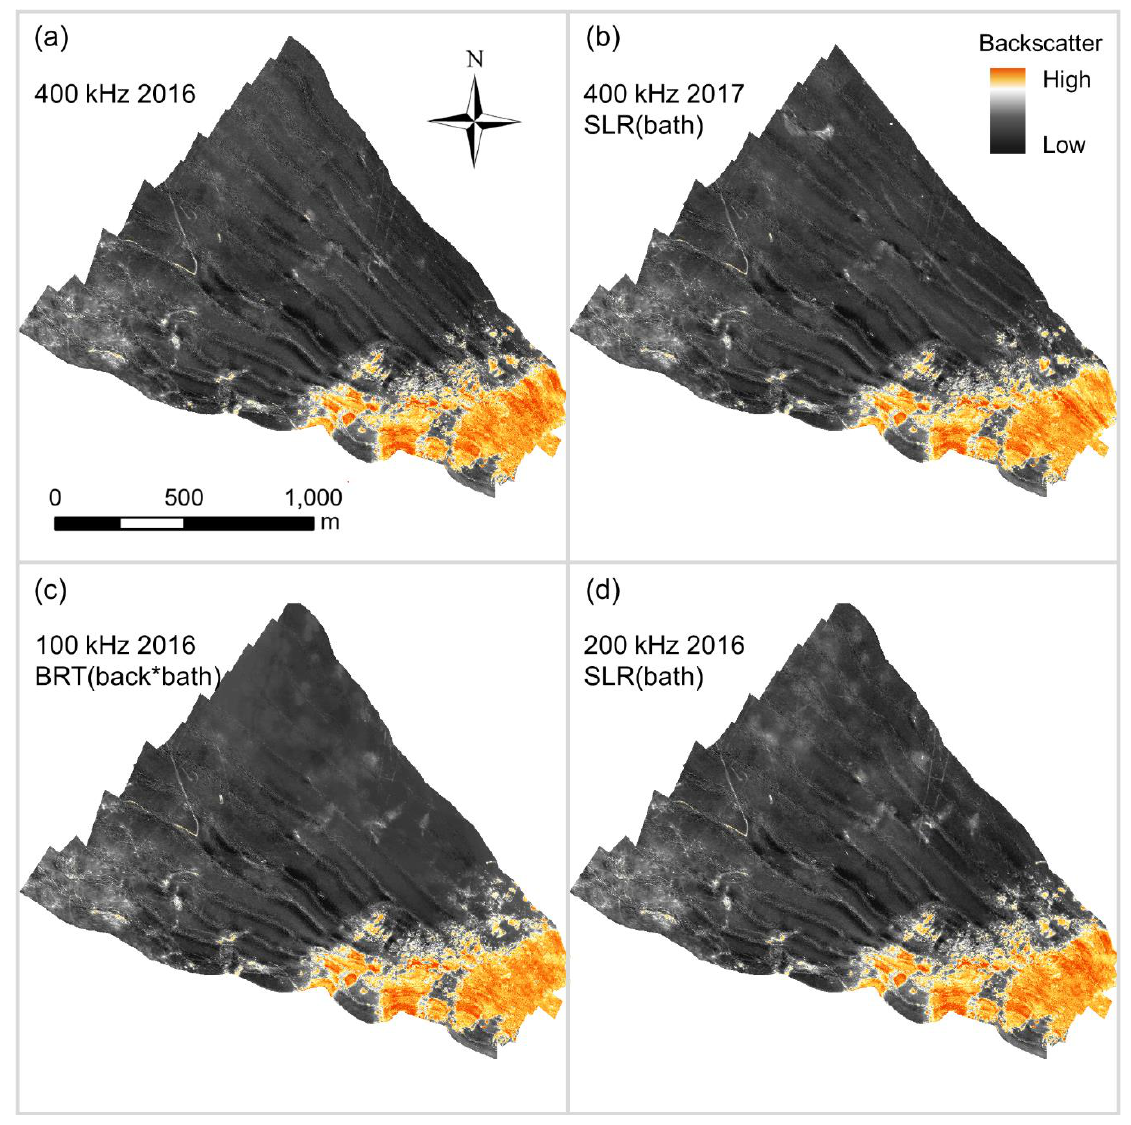
Figure A4. Highest quality bulk shift mosaics of ( a ) the 2016 Bedford Basin 400 kHz dataset, with ( b ) 2017 400 kHz, ( c ) 2016 100 kHz, and ( d ) 2016 200 kHz datasets.